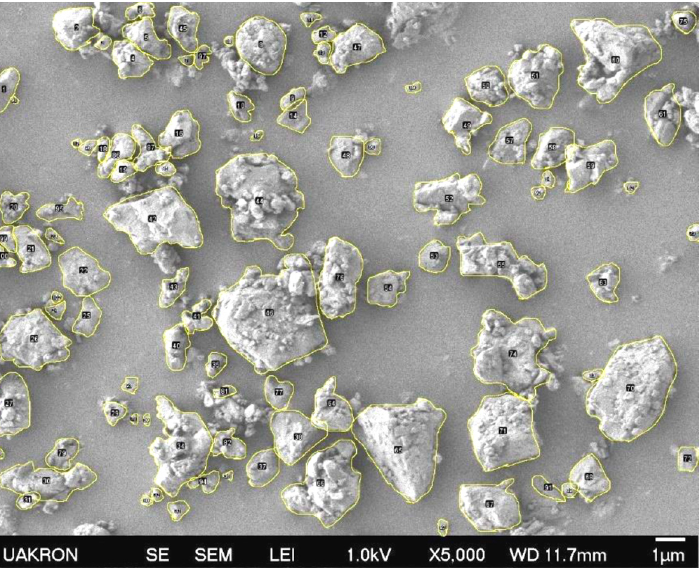
Figure 5. SEM image of GSBH-B particles. The outlined particles were used by the ImageJ software to determine their particle size.